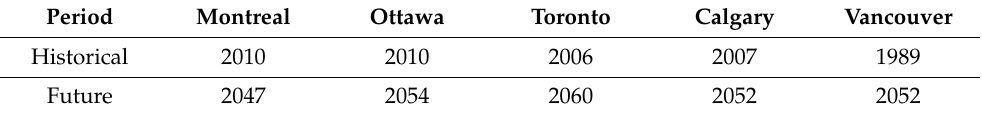
Table 7. Selected extreme weather years for simulation for each city.